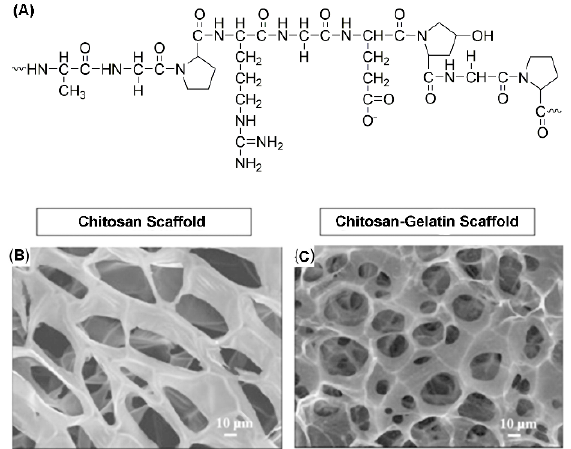
Figure 5. ( A ) The chemical structure of the gelatin. ( B ) Scanning electron microscopy (SEM) images of pure chitosan scaffold and ( C ) chitosan–gelatin scaffold. Redrawn from reference [195]. Copyright 2009 Elsevier Ltd.